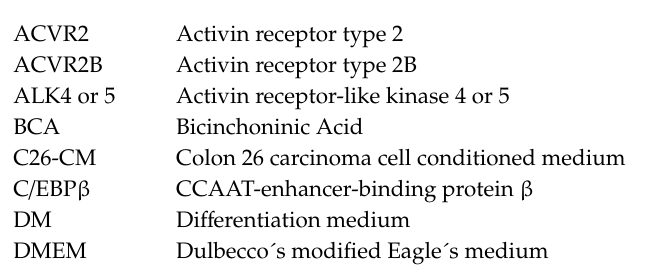
Figure S1: Representative images of the di ff erentiated C2C12 myotubes. Table S1: Antibodies used in western blot (WB) and immunocytochemistry (ICC). Table S2: Primers used in real-time qPCR analyses. Figure S2: Amplicon lengths of the CHQ cell RT-qPCR products. Figure S3: PicoGreen normalization of the RT-qPCR results. Figure S4: Repeated 2-h C2C12 myotube experiment with alternative di ff erentiation protocol (2% horse serum, HS). Figure S5: The coculture of C2C12 myoblasts and myotubes with C26 cancer cells. Figure S6: Protein content of follistatin in C2C12 myotubes di ff erentiated with 2%